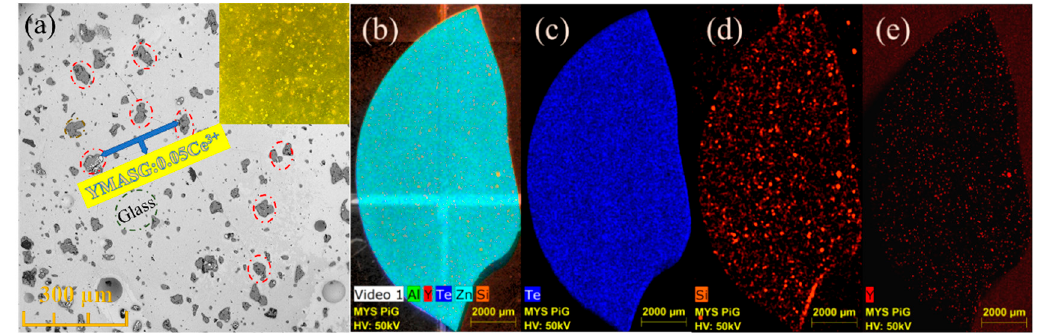
Figure 5. ( a ) The SEM image of the as-prepared PiG sample. ( b–e ) The EDS mapping images of the